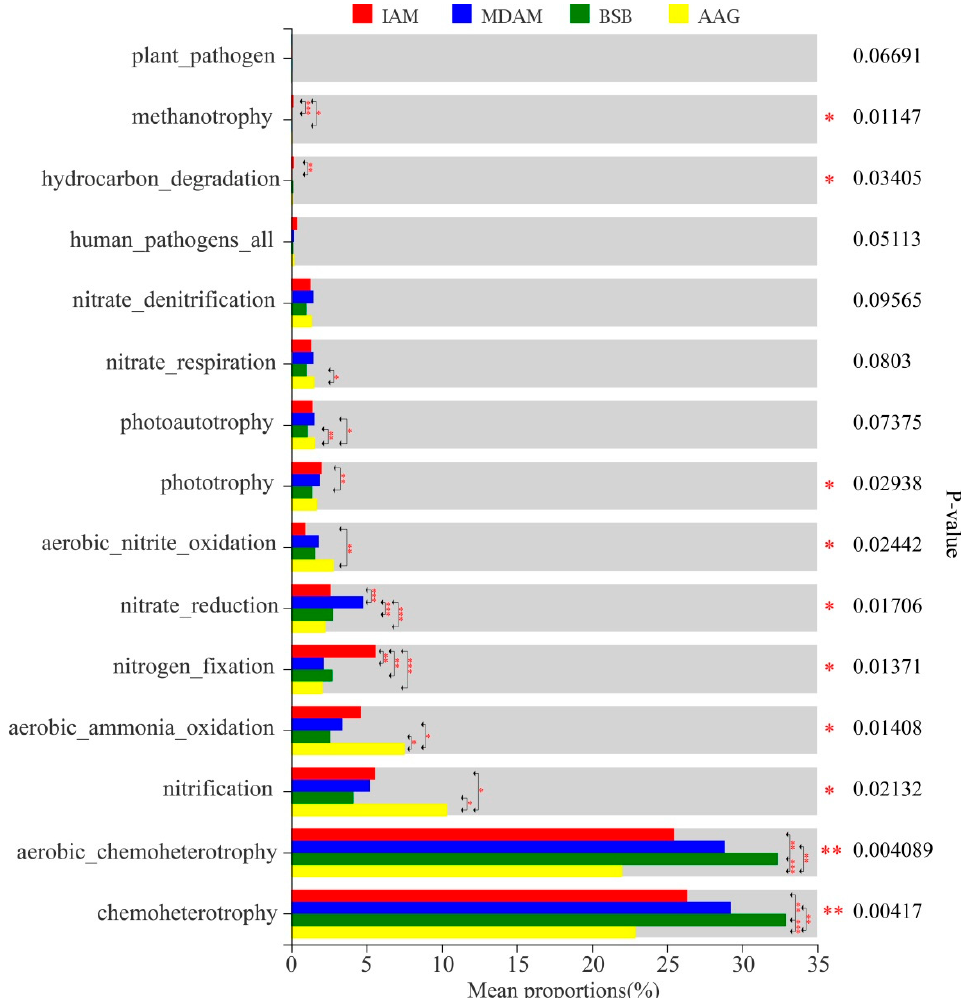
Figure 5. Comparison of the predicted microbial functions among different types of alpine meadows based on the FAPROTAX database (*** p < 0.001; ** p < 0.01; * p < 0.05); IAM, intact alpine meadow; MDAM, moderately degraded alpine meadow; BSB, black soil beach; AAG, artificial grassland.